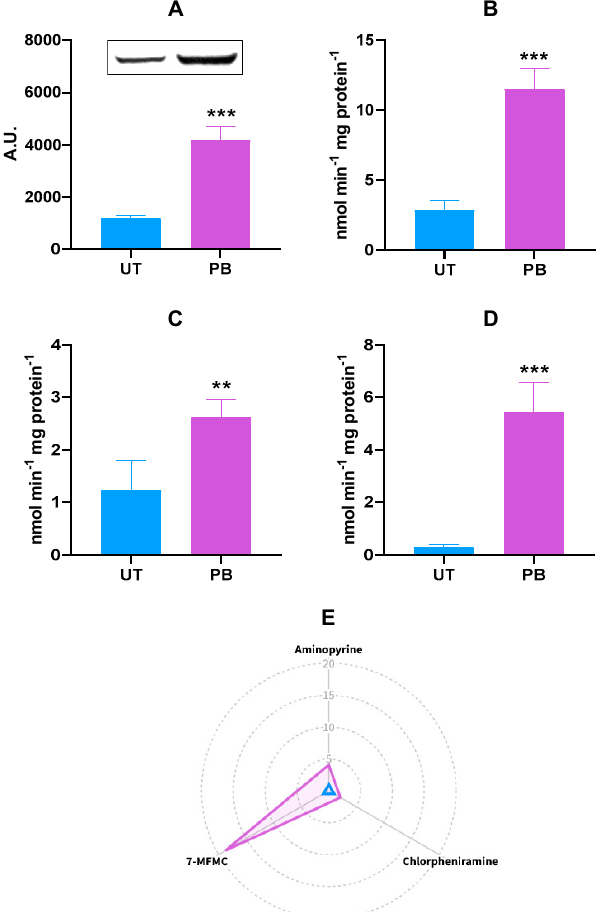
Figure 3. Hepatic CYP2C protein expression ( A ) and in vitro metabolism of CYP2C marker sub- strates aminopyrine ( N -demethylation; ( B )), chlorpheniramine ( N -demethylation; ( C )), and 7-MFMC ( O -demethylation; ( D )) in untreated control (UT, n = 3) and phenobarbital-treated (PB, n = 4) cattle. In the radar plot ( E ), data are expressed in arbitrary units (A.U.), and a value of 1 was attributed to UT cattle. In the bar charts, data are expressed as arithmetic means ± SD. 7-MFMC: 7-methoxy-4-trifluoromethylcoumarin. ** p < 0.01; *** p < 0.001 (unpaired t -test).